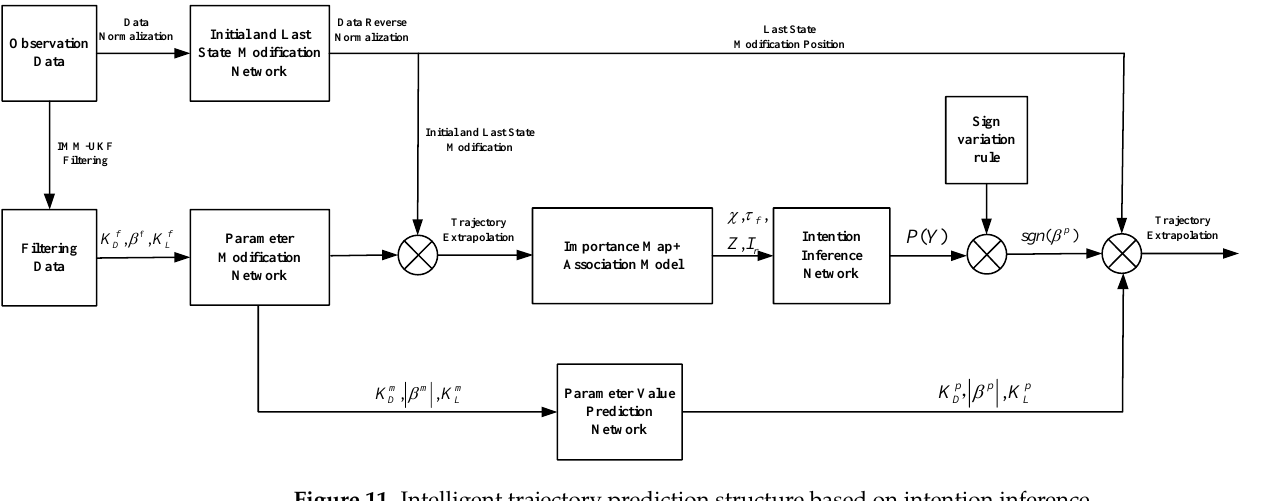
Figure 11. Intelligent trajectory prediction structure based on intention inference